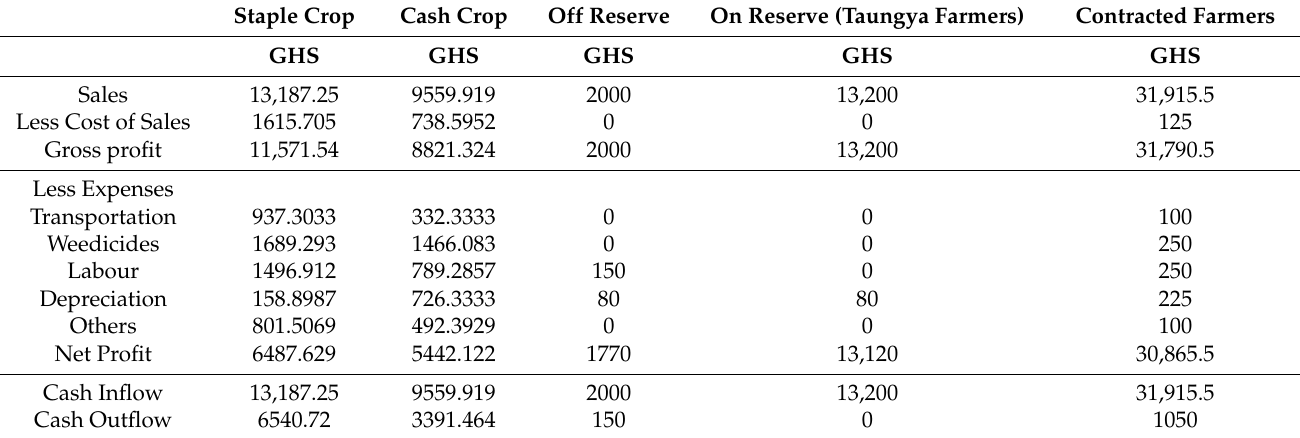
Table 5. Average profit and loss statement for the year ended 2021 for agriculture and woodlot